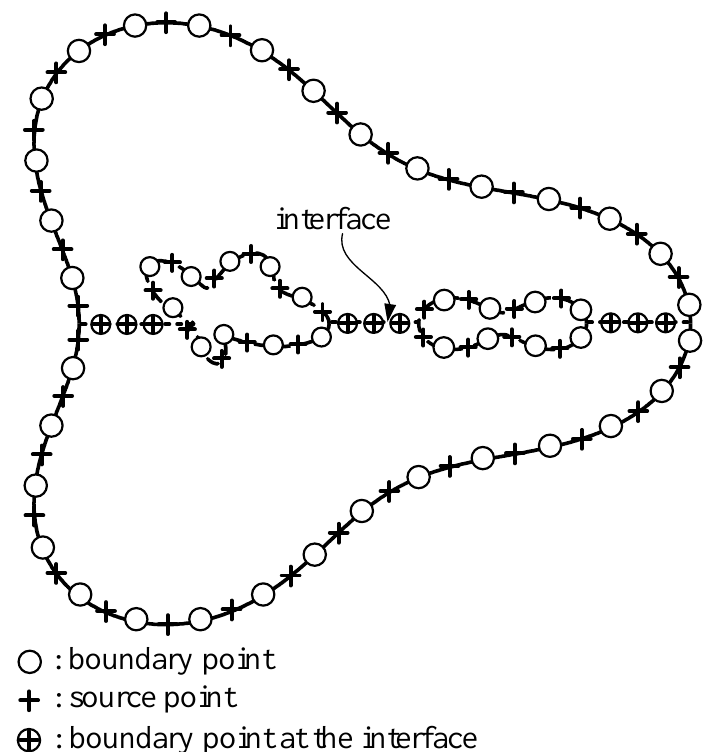
Figure 14. Collocation points for the example bounded by a multiply connected domain.